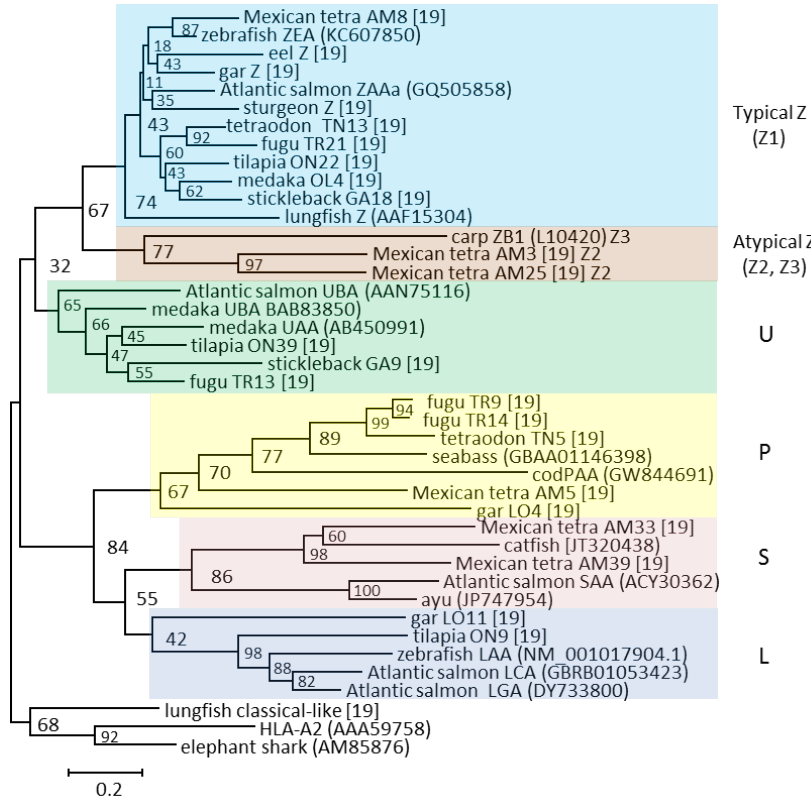
Figure 4. Phylogeny of selected alpha 1 domain amino acid sequences from the five defined lineages is shown using different colored shading. The tree is based on a simplified manually curated alignment from Grimholt et al. [19]. The tree is drawn to scale, with branch lengths representing the number of amino acid substitutions per site (see scale bar). Bootstrap values in percentage based on 1000 trials are shown on each internal node. The atypical Z lineage definitions Z2 and Z3 are shown behind the sequence names. GenBank sequence references are in parentheses while the remaining sequences can be found in